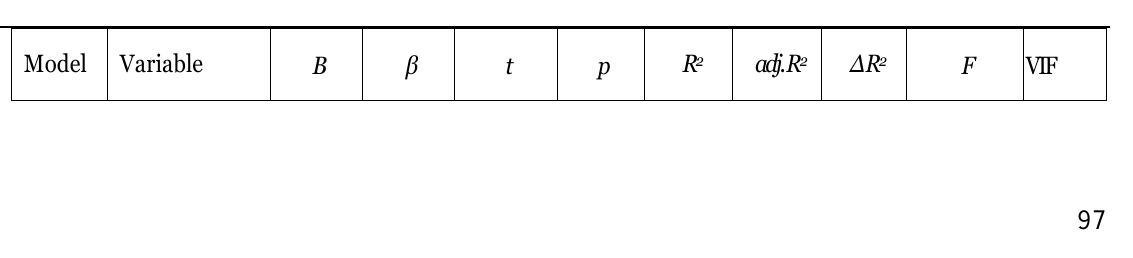
A Test of Buffering Effect of Interaction with Learner on the Relationship of Learning-Related Anxiety and Intention to Persist.